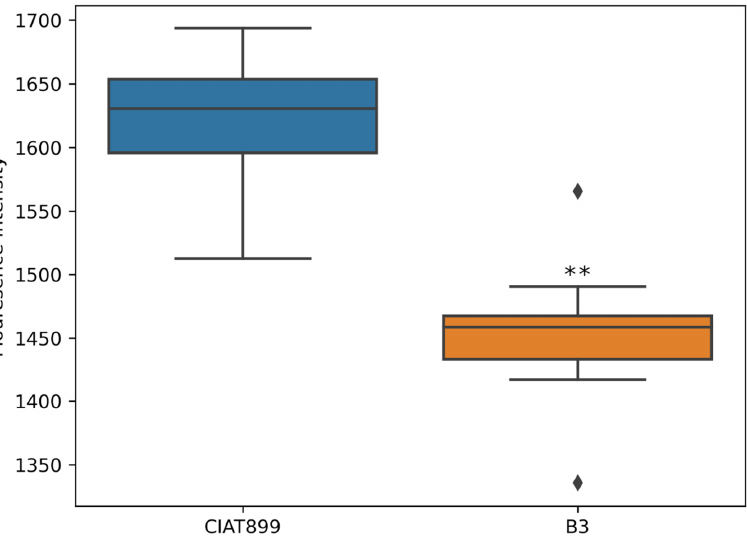
Figure 3. The fluorescence signals from Calcein bound to the plasma membranes of Al treated rhizobia cells and untreated control exemplarily quantified with a fluorescence plate reader. Asterisks represent significance differences between fluorescence intensity from CIAT899 and B3 (one-way ANOVA; ** p ≤ 0.001).